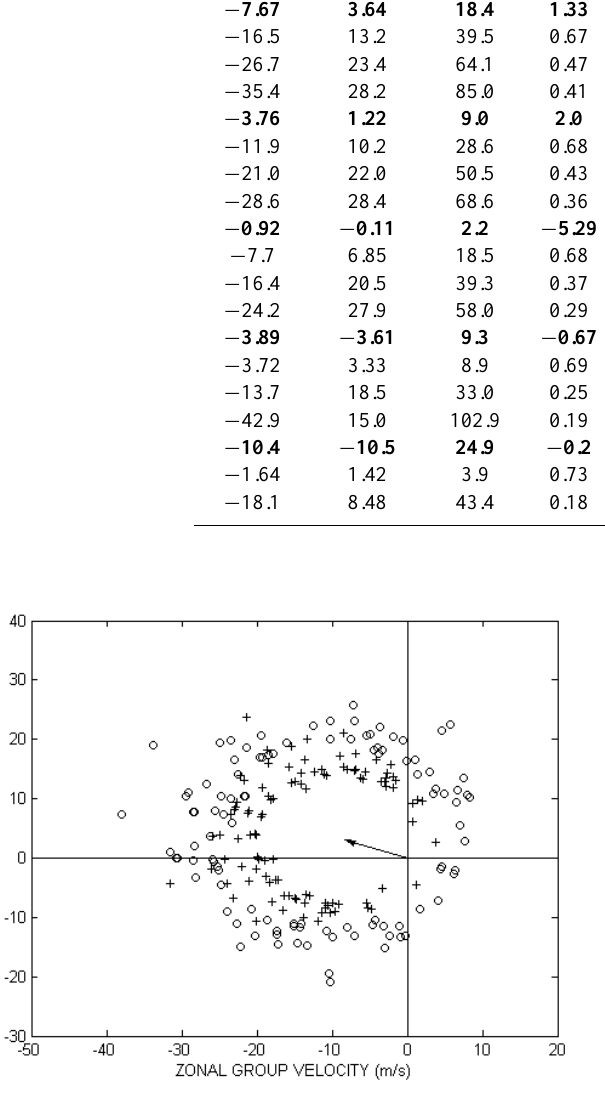
Fig.5 Same as Fig.4 except that the data were from the upward moving gravity wave Fig. 5. Same as Fig. 4 except that the data were from the upward packets of the summer data set. moving gravity wave packets of the summer data set.